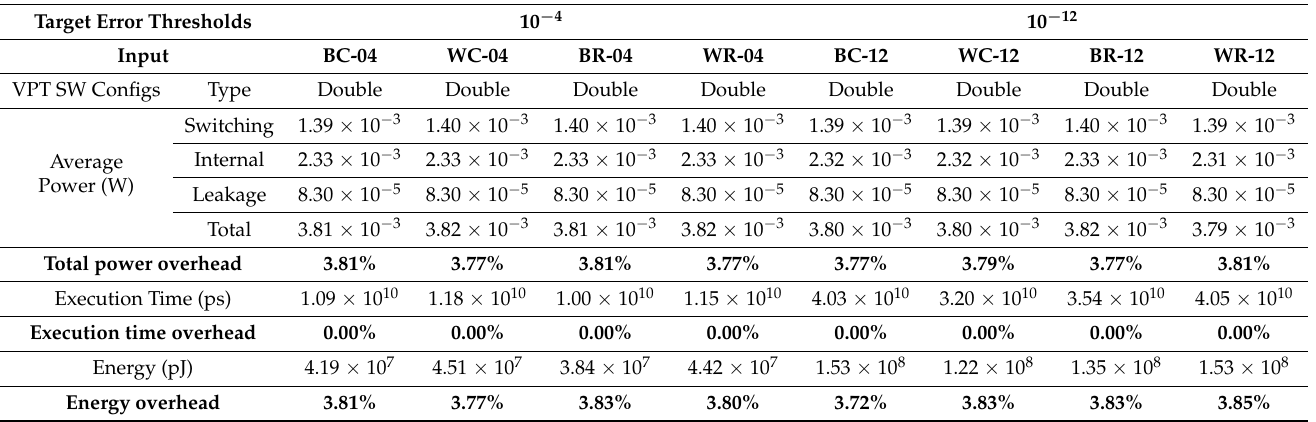
Table 4. Power, execution time, and energy consumption overheads of the standard double precision version of Jacobi executed on the VPT_H configuration of the VPT-FPU.